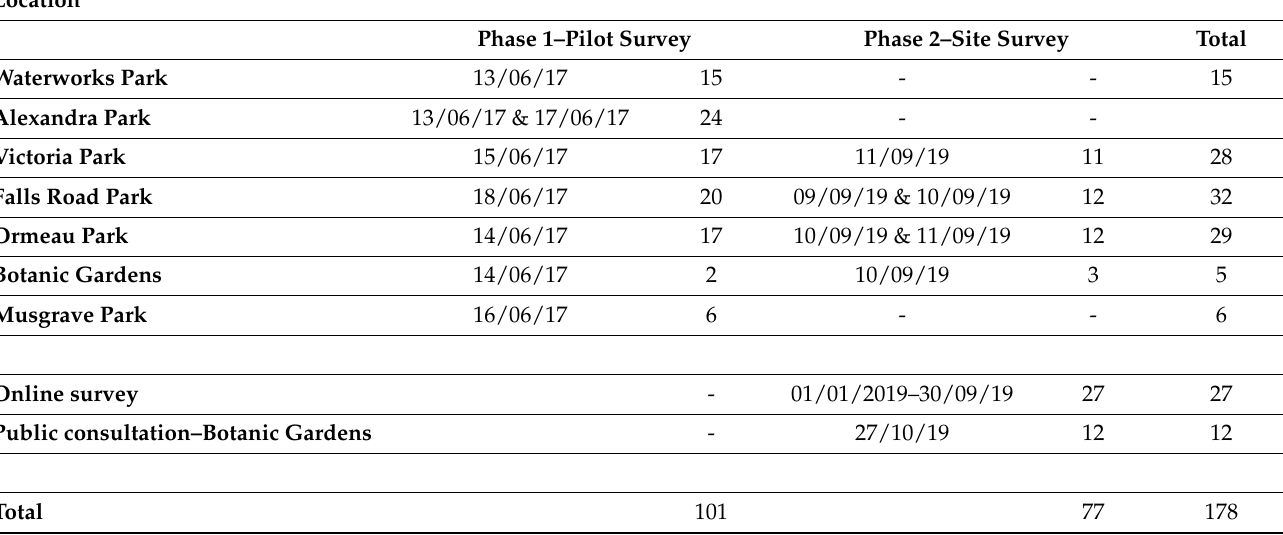
Table 1. Site survey